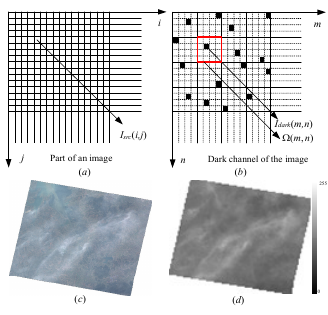
Figure 2. Detecting the dark pixels of original images.